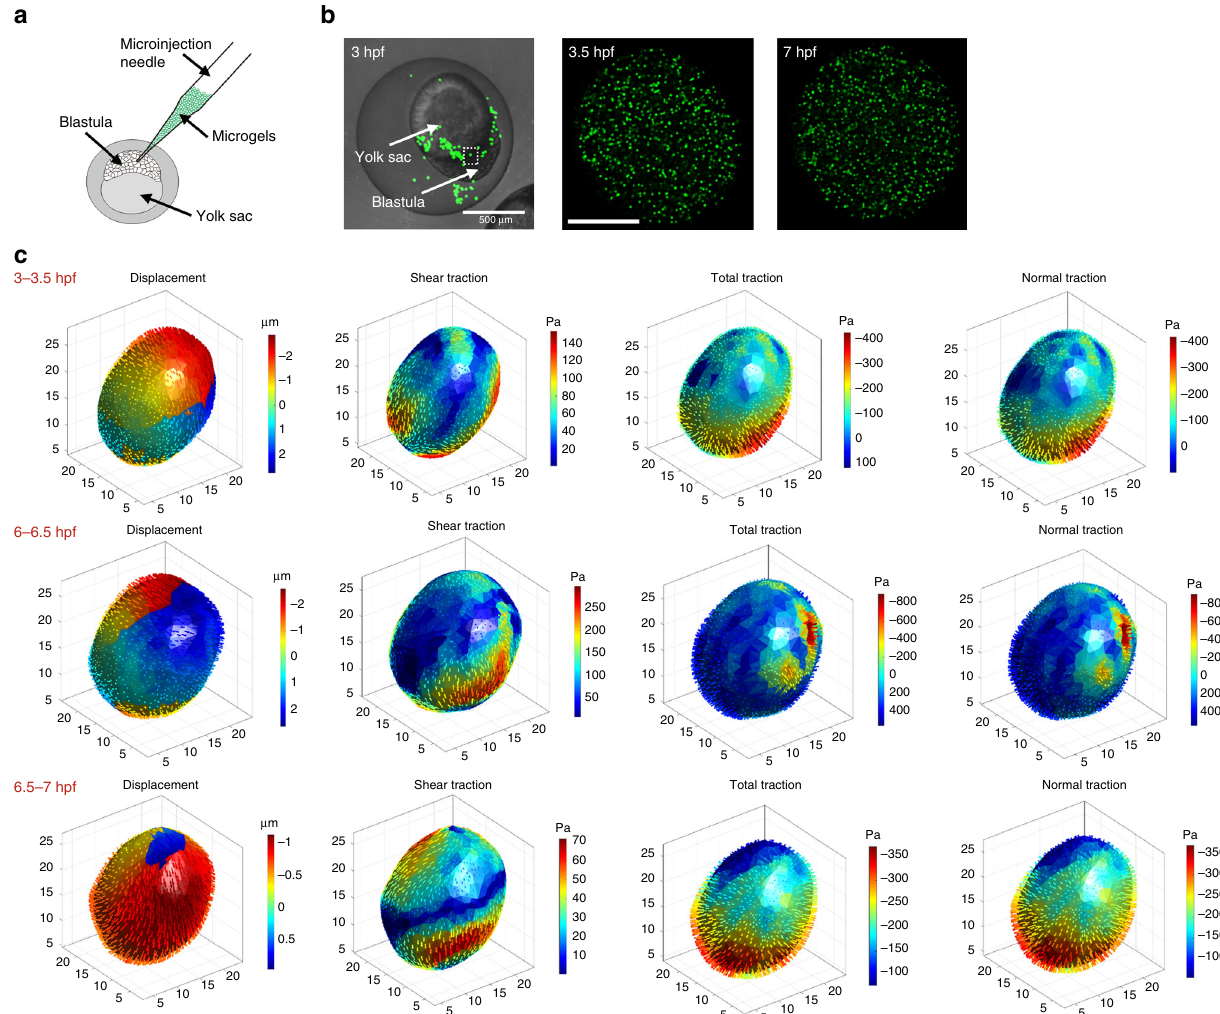
Fig. 9 Quantifying tractions in a zebra fi sh embryo. a Schematic of microinjection of ERMGs onto a zebra fi sh embryo at the blastula stage by puncturing the outer membrane of the zygote and injecting into spaces surrounding the embryo. b A low-resolution confocal image (left) showing the whole embryo at the blastula stage (3 hpf, hours post-fertilization) and the injected ERMGs onto the embryo. The dashed white line box circles the microgel that is zoomed in for high-resolution imaging at different developmental stages: 3.5 (middle) to 7 (right) hpf. Scale bars: left, 500 µ m; middle, 10 µ m. c 3D maps of displacement (left), shear traction (middle left), total traction (middle right), and normal traction (right) of an ERMG. The 3D confocal images of the ERMG were taken starting at 3 hpf, then at 3.5, 6, 6.5, and 7 hpf, respectively. The 3 – 3.5 hpf images (top row), 6 – 6.5 hpf images (middle row), and 6.5 – 7 hpf images (bottom row) are different in displacements or tractions analyzed between those 30-min intervals. Note that since the zero traction condition cannot be obtained in live embryos, only changes in tractions can be